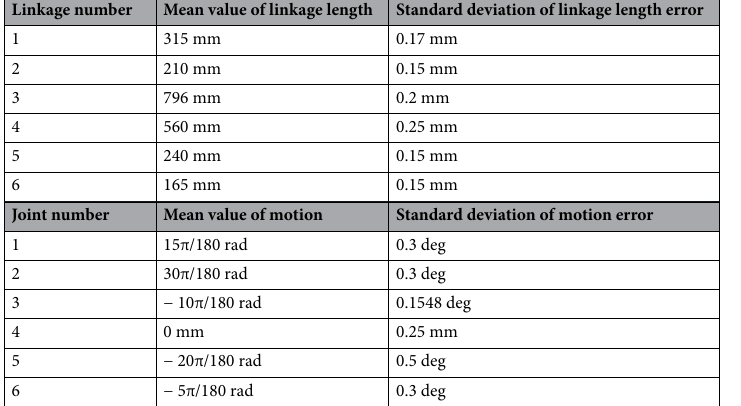
Table 2. Error distribution table of the tool-changing